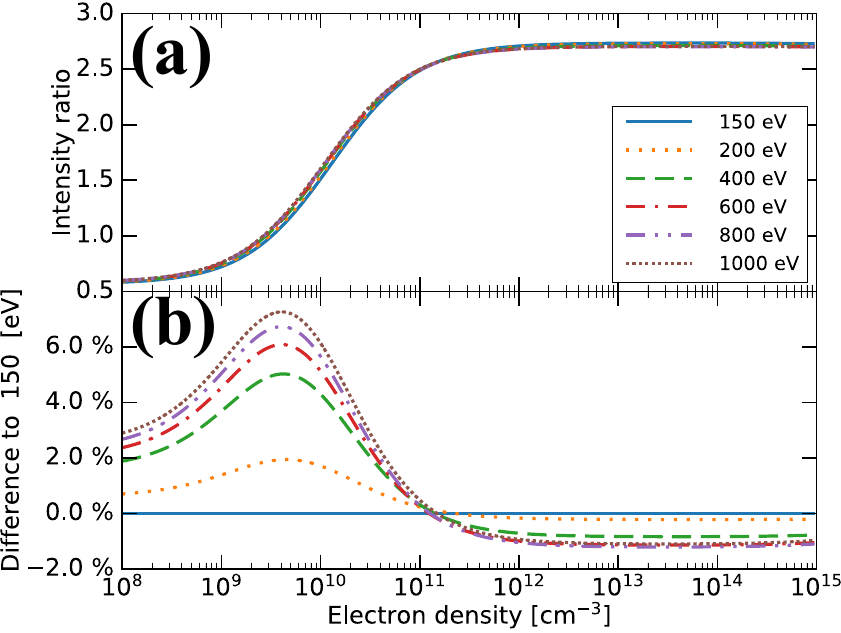
Figure 4. ( a ) Electron density dependence of Fe XIV 264.785 Å/274.203 Å intensity ratio for various temperatures for IoEx0p1 model. ( b ) Difference in intensity ratio relative to case of 150 eV at each